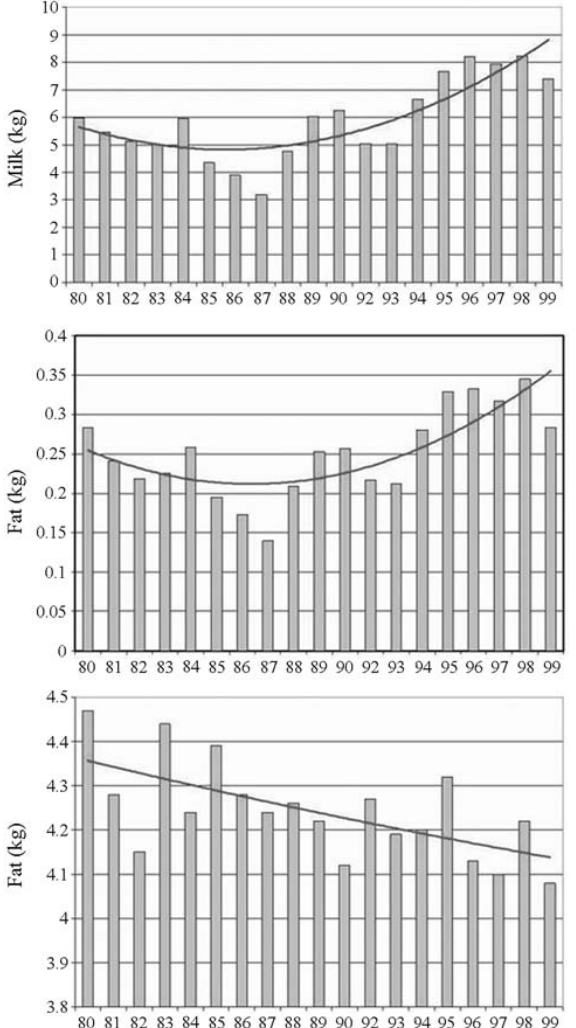
Figure 2 - Effects of days in lactation on milk yield (MY), fat yield (FY) and fat percentage (FP) of crossbred Holstein-Zebu